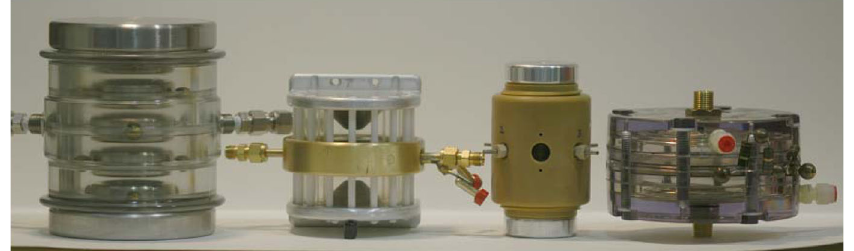
FIG. 5. (Color) Side-by side comparison of the four gas switches tested in these experiments.